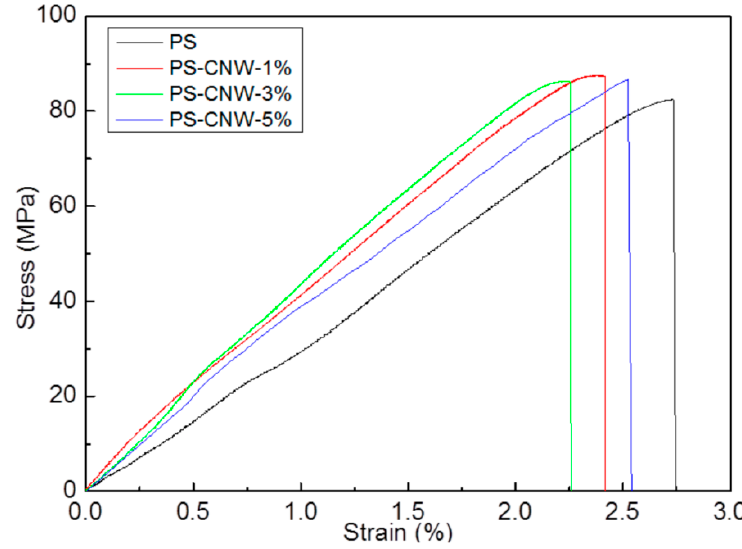
Figure 8. Transmission electron microscopy (TEM) images of PS-CNWs-3% nanocomposite ( a – d ).